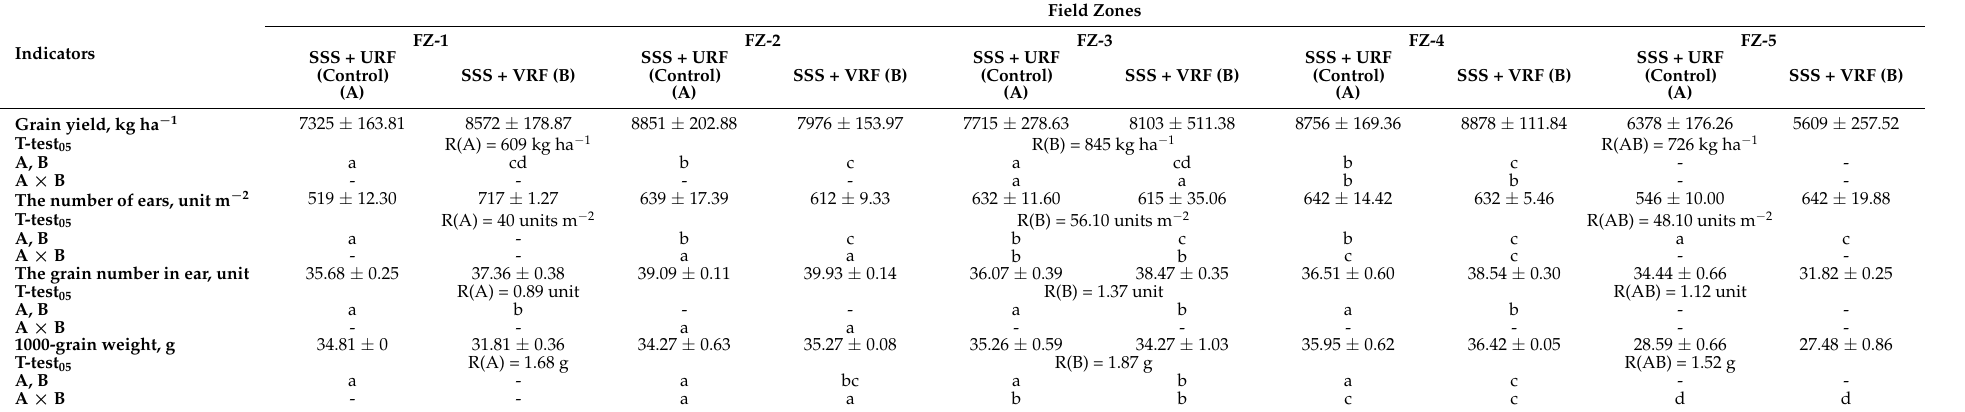
Table 1. Winter wheat productivity